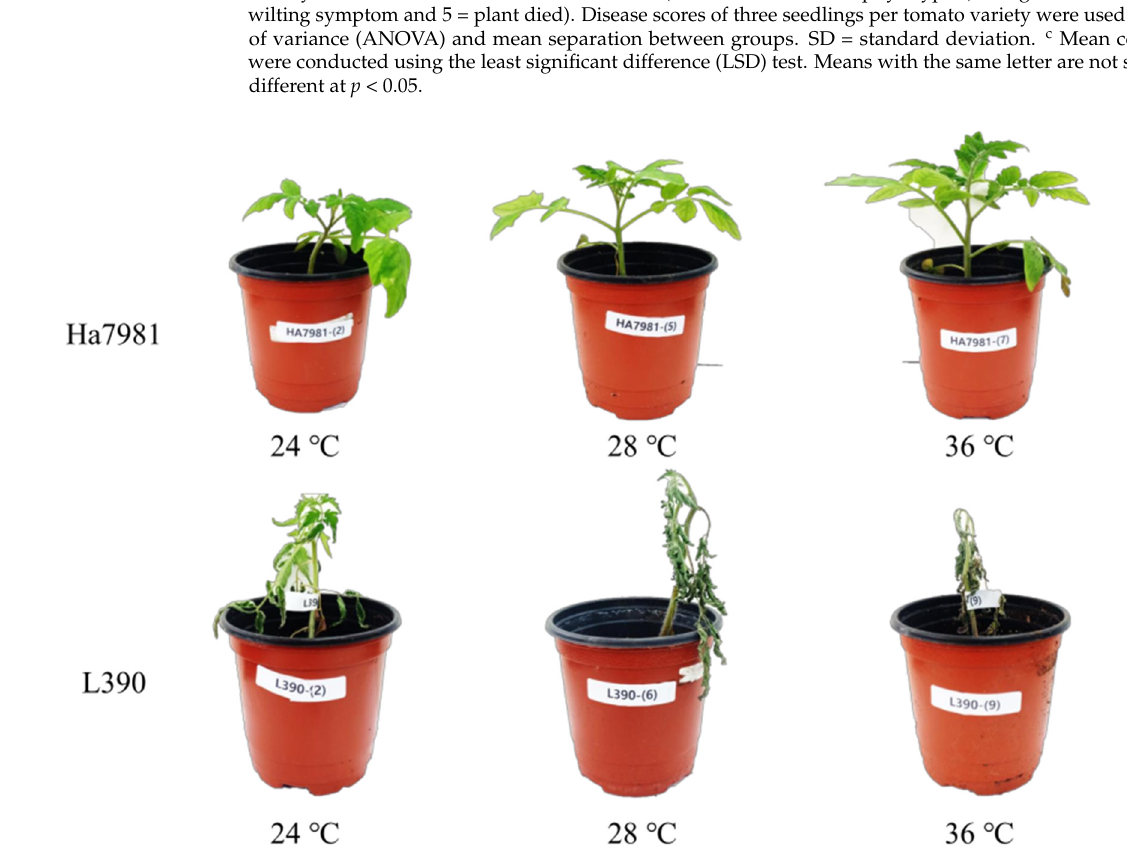
Figure 2. Bacterial wilt progress in the three groups (R, R/S, and S) of 50 tomato varieties at three ambient temperatures (24 °C, 28 °C, and 36 °C). Each group consisted of 25 (R group), 15 (R/S group), and 10 (S group) varieties. The five-week-old seedlings were inoculated with the WR-1 strain (race 1, biovar 4, and phylotype I) and disease progress was scored for seven days after inoculation using the 1–5 rating scale (1 = no wilting symptom and 5 = plant died).